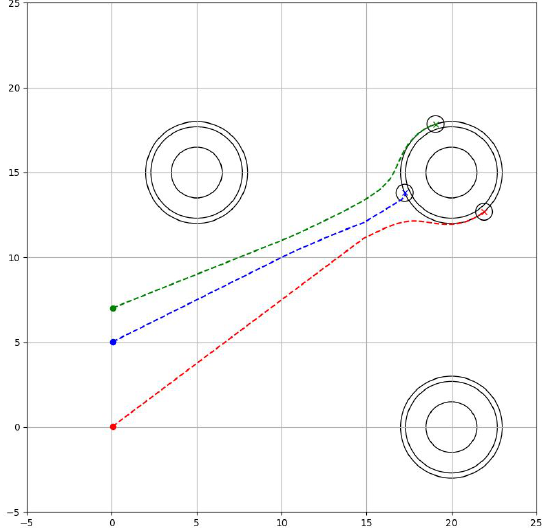
Figure 10. Formation